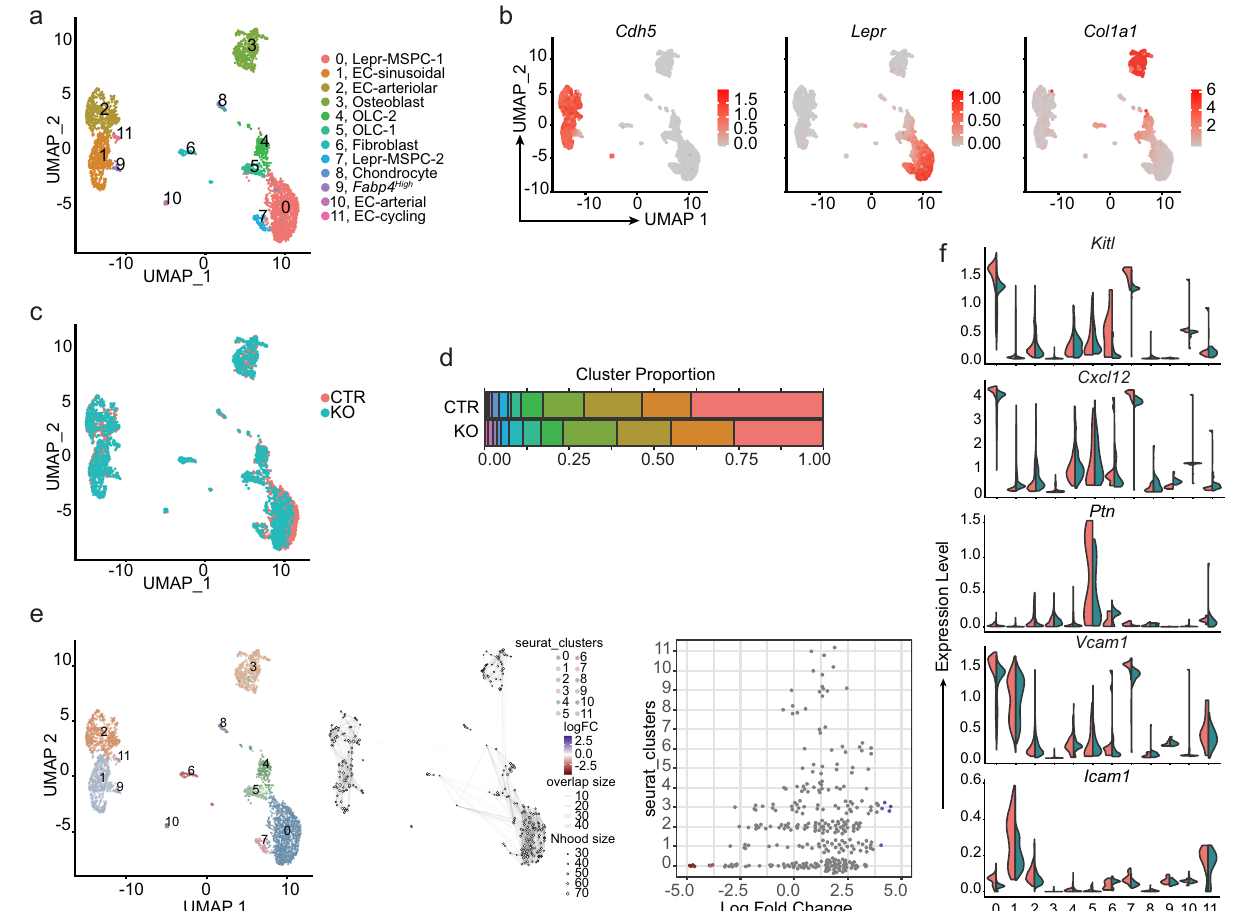
Fig. 4 | Niche cell transcriptional heterogeneity in mice with CXCR4-de fi cient MPPs.a UMAPvisualizationofbonemarrownon-hematopoieticcells. b Expression levels of genes associated with endothelial cells ( Cdh5 ), MSPCs ( Lepr ), and osteo- lineage cells ( Col1a1 ) overlaid on UMAP. c Overlay of UMAP visualization of bone marrow non-hematopoietic cells from Flk2-cre.Cxcr4 fl /+ (CTR, red) and Flk2- cre.Cxcr4 fl / fl (KO, blue) mice. d Cluster proportion. e Differential abundance test with Milo. UMAP cluster representation (left); graph representation of Milo dif- ferential abundance testing (middle); Beeswarm plot showing the distribution of